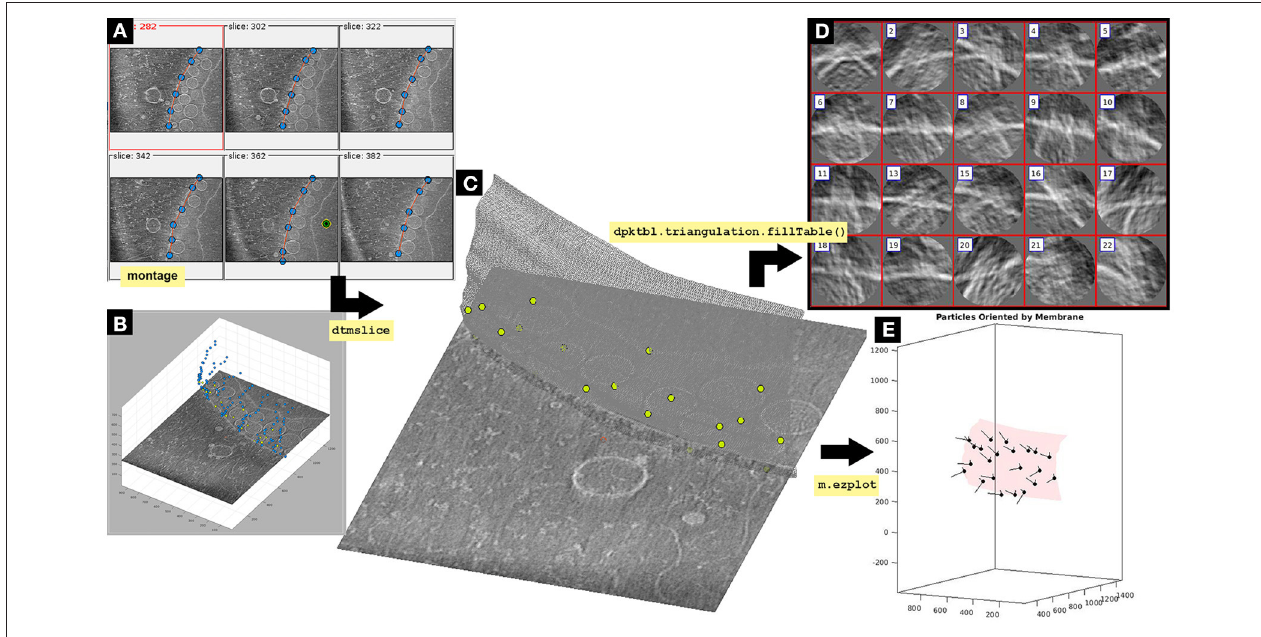
FIGURE 3 | Imparting orientation with a membrane surface Dynamo model. The OMM is modeled by a triangulated mesh based on a set of manually picked points. In dynamo tomogram slice (dtmslice) membrane points are picked using a montage ( Montage > Create Montage of full depicted scene ) to manually click on a set of membrane points. By default, this montage shows slices orthogonal to Z, extracted every 20 pixels of the non-binned tomogram (A) . Montage settings can be modified by the user ( Montage > Change montage settings) . Create a new membrane model in the montage GUI following: Model Pool > Create new model in pool (choose type) > Surface . Activate the [c] and [i] montage GUI button to insert points on this interface by activating the point switcher in the montage toolbar ( c-i button). The points are also shown in the 3D model displayed in the depiction box of dtmslice (B) . Explore the tomogram along the Z-view in the montage GUI by clicking on the arrow buttons at the bottom. The membrane is modeled as a surface where points are manually picked by pressing [i] or left-clicking with the mouse. Importantly, points should be clicked in the same order from slice to slice in order to get a smother triangulation in next steps of the protocol. Points should be picked in the slice where the OMM is clearly seen, and can be deleted by pressing [d] or right-clicking on top of the point that will display an option menu. For semiautomatic detection of points in Z-slices above and below a reference slice, activate the Z-slice where the semiautomatic detection is desired, leave the mouse on top of the activated Z-slice and press the key [o] . The surface that should be modeled is the membrane where the neck of the viral spherules is inserted ( Supplementary Figure S1 ). Importantly, defining the interior side of the membrane model is essential to impart the right orientation to the particles. Leave the mouse on the point where the center is defined and press the keys [shift] and [c] . A green and yellow point is created on the inside of the membrane ( A , green and yellow dot). The model is saved into the catalogue [ Active model > save active model into catalogue (disk) or save all current models in pool by: Model pool > Save all models into catalogue ]. (A) Montage window representing the XY plane of selected tomogram slices. Blue dots represent membrane surface points linked by a red line that simulates the continuity of the modeled membrane. The green, black and yellow bull’s eye point represents the inside side of a mitochondrion. (B) Tomogram slice displayed in dtmslice . The OMM is represented as blue dots, this is what the user visualizes in dtmslice when picking the membrane model points in the montage GUI. The FHV docking site particles are represented as green dots. (C) Tomogram slice displayed in dtmslice . The OMM is represented as a gray triangulated surface containing the FHV docking site particles modeled as green points along the membrane surface. Importantly, the goal of this figure is to visualize the two final models unequivocally [particles (green dots) and membrane]. At this point, no surface triangulation is required, albeit later in this protocol triangulation is performed (see Figure 7 ). (D) Oriented particles obtained by imparting orientation with the membrane using dpktbl.triangulation.fillTable to obtain a table containing the geometrical information of the membrane surface used to impart the correct orientation to the particles. (E) Graphical representation of the mitochondrial membrane as a red triangulated surface with the normal vector (black line) of the FHV particles (black dots) pointing in the right direction, toward the outside of the membrane. The Z orientation computed for each particle is represented by the longest